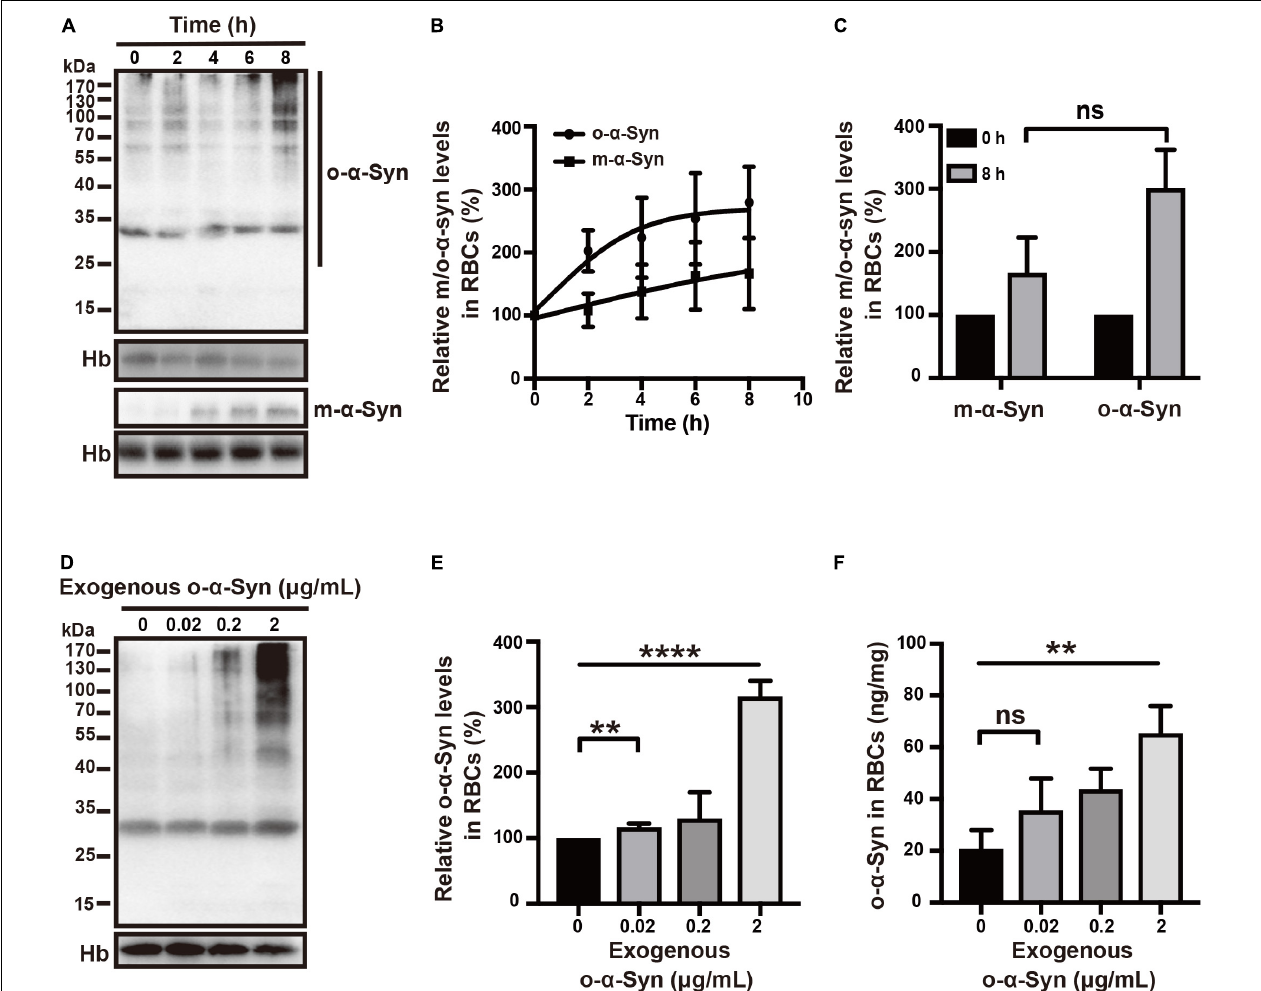
FIGURE 4 | Time- and concentration-dependent changes in RBC o- α -Syn levels. (A) 2 µ g/mL of m- α -Syn or o- α -Syn was added to RBCs incubation buffer and intracellular m- α -Syn and o- α -Syn levels were measured at different time points using Western blot. (B) Intracellular m- α -Syn ( r = 0.9737, p < 0.01) and o- α -Syn ( r = 0.9398, p < 0.05) levels increased in an incubation time-dependent manner. (C) Increase in o- α -Syn levels was more significant than that in m- α -Syn levels without significant difference. (D) Intracellular o- α -Syn levels increased with the increase in extracellularly added o- α -Syn. (E,F) Concentration-dependent increase in intracellular o- α -Syn. n = 3; ** p < 0.01, **** p < 0.0001; ns, not significant. Hb, hemoglobin.